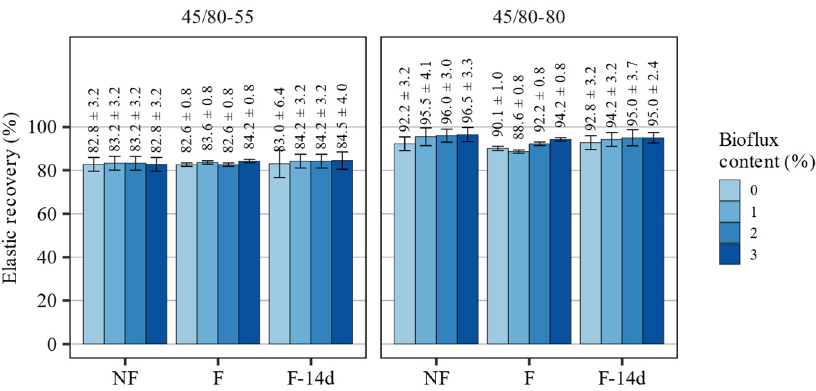
Figure 4. Results of elastic recovery measurements of the investigated asphalt binders.